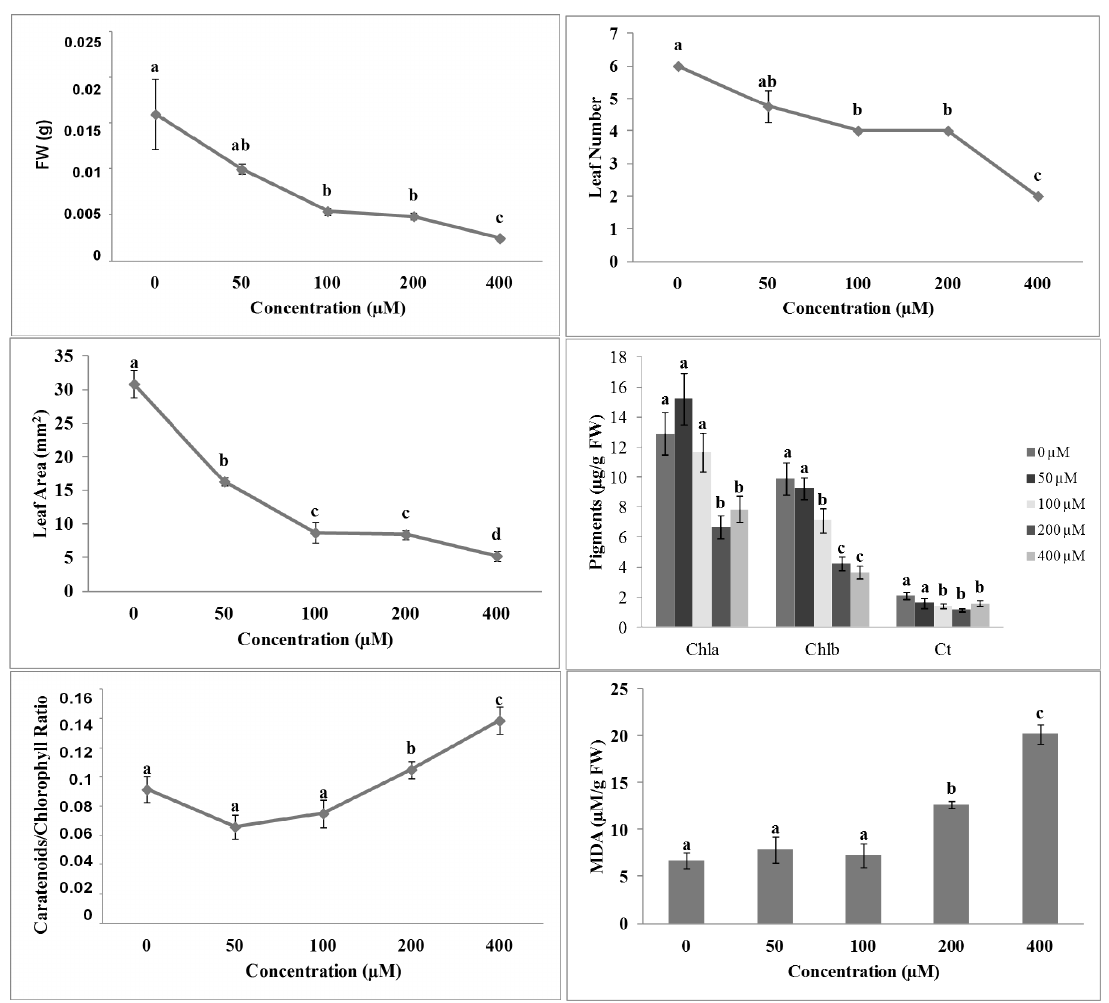
Figure 2. Morpho-physiological parameters of A. thaliana seedlings treated with different concentrations of the compound 2 : Shoot Fresh Weight (SFW), Leaf Number (LN), Leaf Area (LA), pigments content, Carotenoids:Chlorophyll Ratio and MDA content. Different letters along the curves indicate significant differences at p ≤ 0.05. All data were analyzed by ANOVA, applying Tukey’s and Tamhane’s T2 tests for homoscedastic and heteroscedastic parameters, respectively ( N =